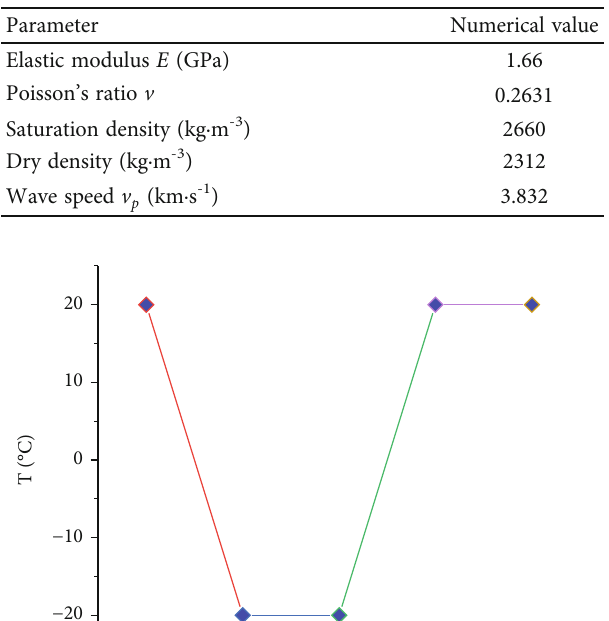
Table 1: Basic physical parameters of red sandstone.